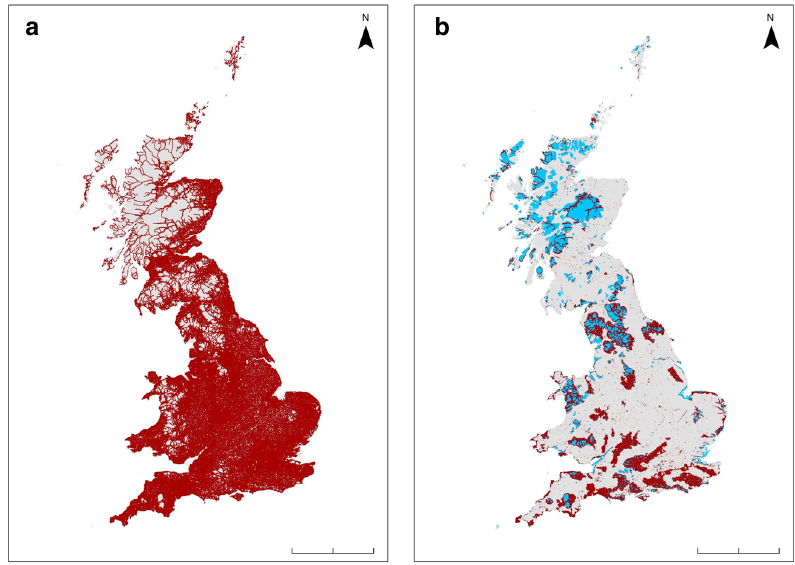
Fig. 7 Areas of Great Britain and terrestrial protected areas within 700 m of a road. Blue represents terrestrial protected areas and red represents areas of a Great Britain and b terrestrial protected areas within the mean effect distance, 700 m, of associations between roads and bird abundance variation. Scale bars denote 200 m. Great Britain boundary shape fi le obtained from ONS 74 .